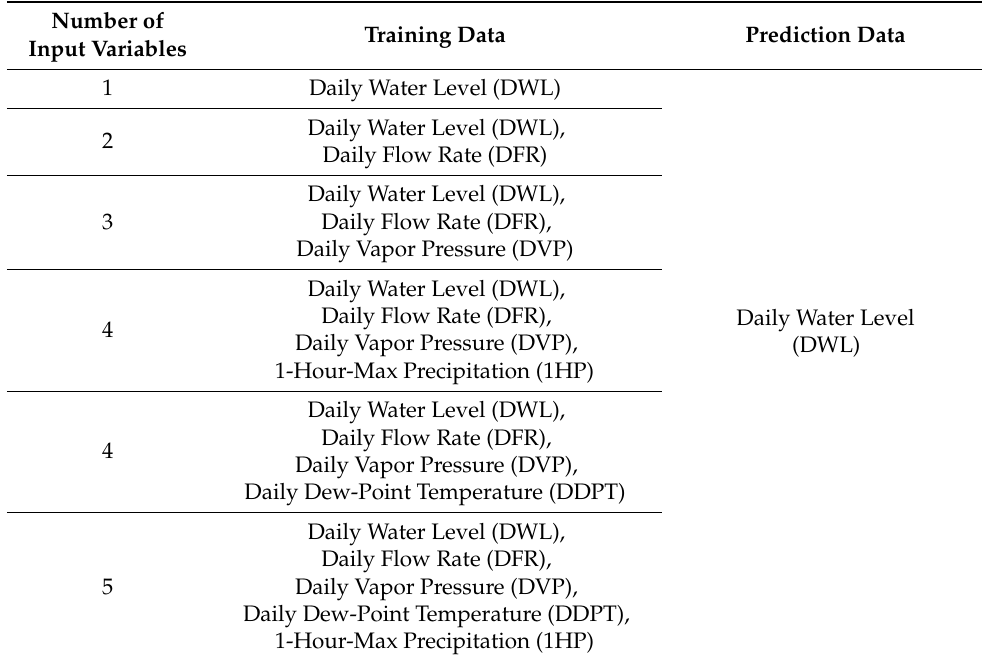
Table 7. Composition of input and output data of LSTM and GRU